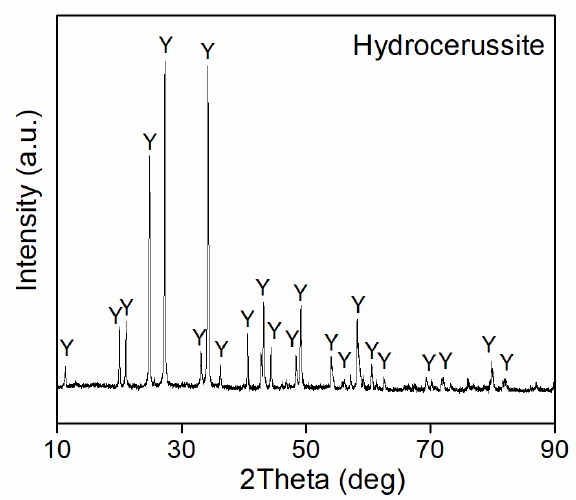
Figure A11. XRD result for lead white. Hydrocerussite (Y) was identified.